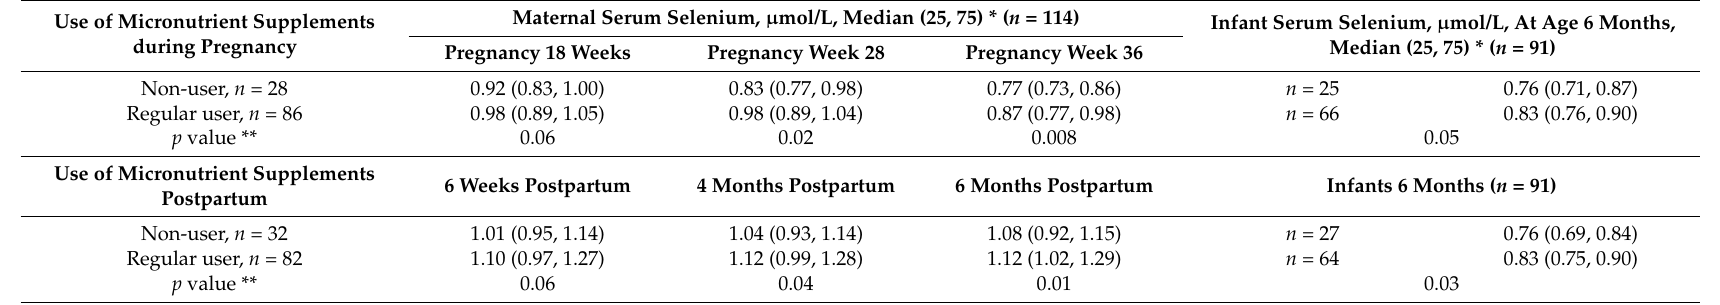
Table 3. Maternal and infant serum selenium according to maternal use of micronutrients in pregnancy and postpartum. Use of Micronutrient Supplements during